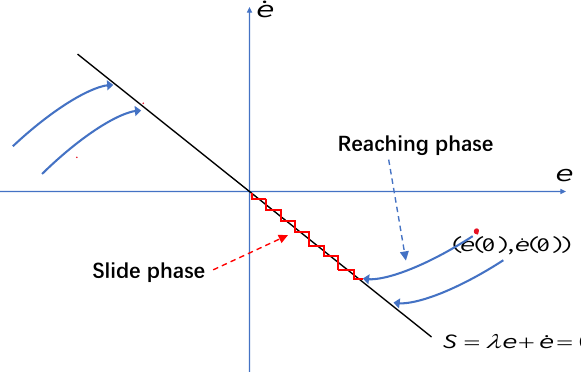
Figure 2. Sliding mode mechanism in phase